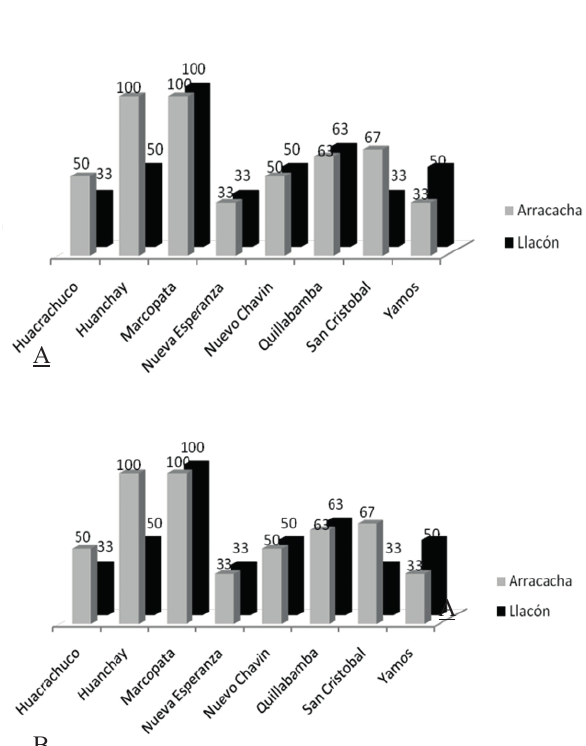
Figure 1. Conservation communities according to the percentage of farmers who conserve between one and three morphs of arracacha ( A. xanthorrhiza ) and yacon ( S. sonchifolius ) in the districts of Huacrachuco (A) and San Pedro de Cholón (B).